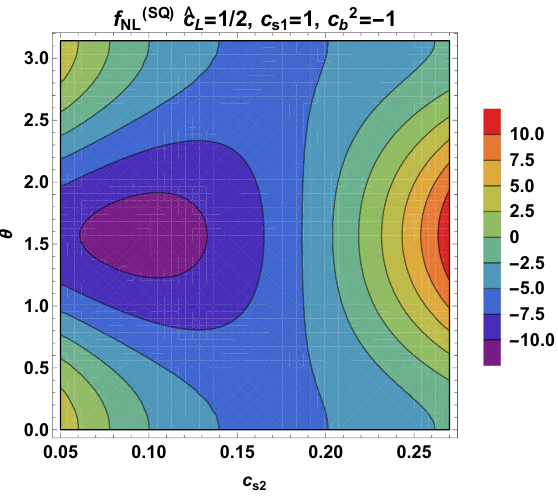
Figure 3 . Plot of the total squeezed f NL with λ 9 = 0 . 05